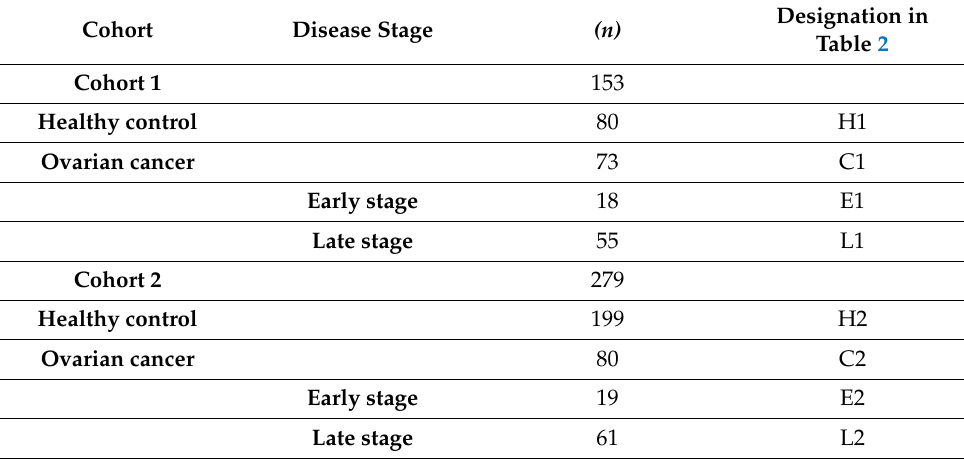
Table 1. Breakdown of each sample population in each